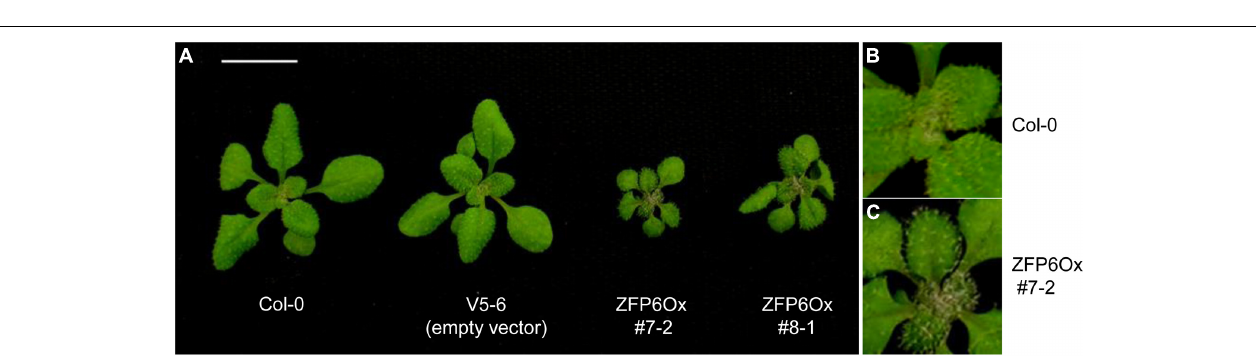
FIGURE 5 | Phenotypes of 35S:ZFP6 overexpression (OX) transgenic lines. (A) Rosette structure of Arabidopsis Col-0 WT, vector control (empty vector, i.e., V5-6), and the 35S:ZFP6 OX transgenic lines 7-2 and 8-1. Trichome formation in (B) Col-0 WT and (C) ZFP6 OX 7-2 line.